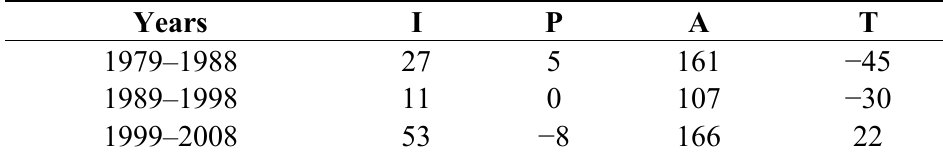
Table 3. CO emissions and driving forces in rural China (growth in 2